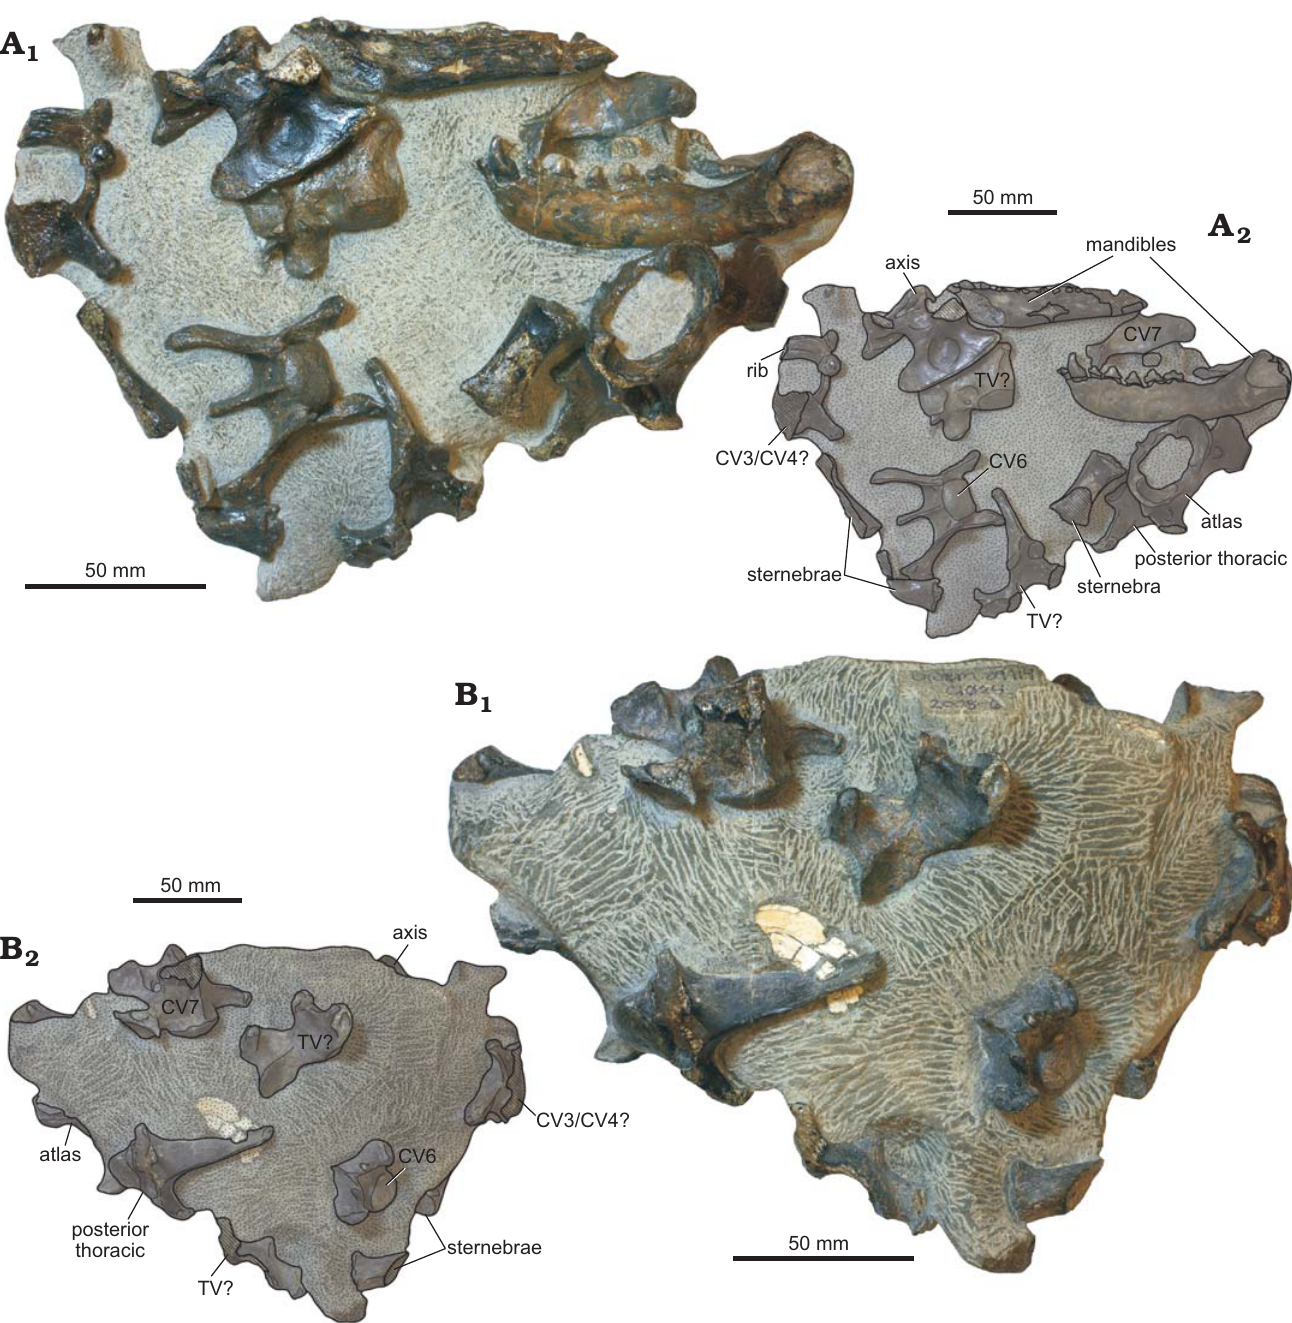
Fig. 6. Mandibles and vertebrae of pinniped mammal Enaliarctos sp. (UWBM 89114) from Moolack Beach, Lincoln County, Oregon, Astoria Formation, late early Miocene. Two sides of the block ( A , B ). Photographs (A 1 , B 1 ), explanatory drawings (A 2 , B 2 ). Abbreviations: CV, cervical vertebra; TV, thoracic